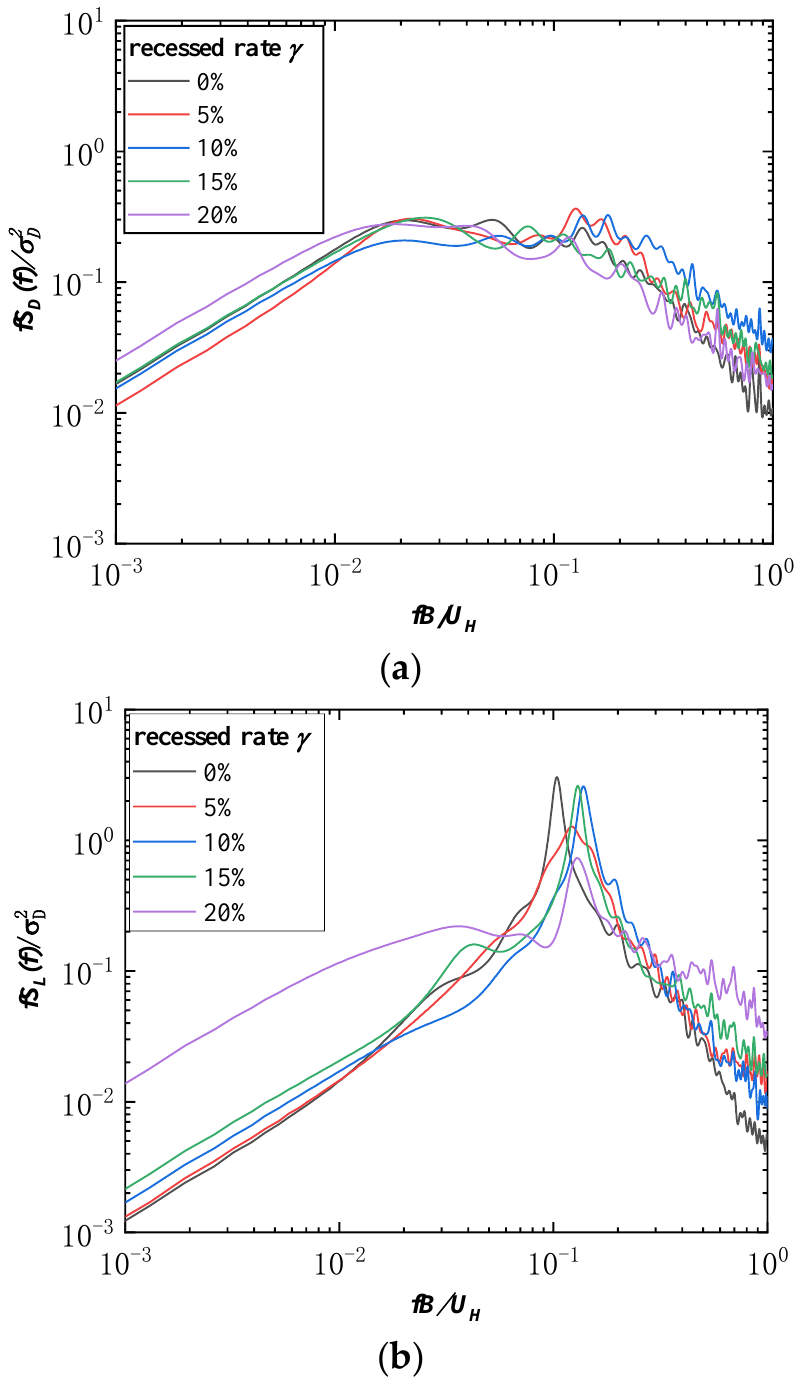
Figure 10. The power spectra of local wind force coefficients at 2/3 H of the five models. ( a ) The power spectra of drag force coefficients. ( b ) The power spectra of lift force coefficients.